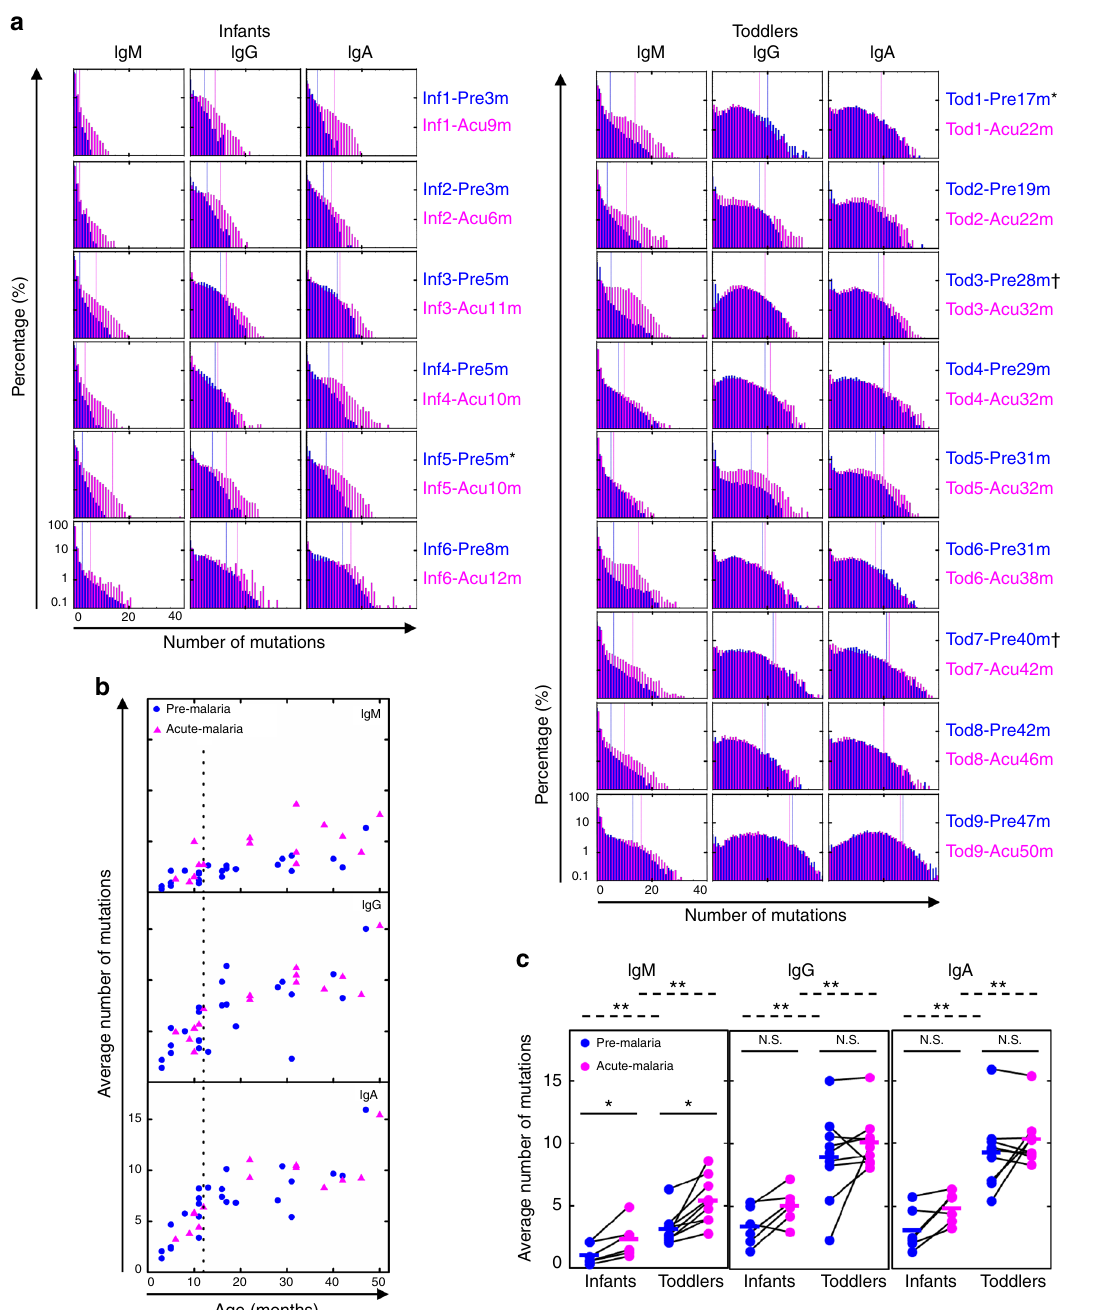
Fig. 2 Infants and toddlers are separated into two stages based on SHM load. a Distribution of SHM number for infants ( N = 6) and toddlers ( N = 9), from whom we had paired pre-malaria ( blue ) and acute ( pink ) malaria samples, weighted by unique RNA molecules. Blue and pink long vertical lines represent the number of mutations above which 10% of sequences fall for the respective samples. * and † demarcate samples derived from the same individuals followed for two malaria seasons. b Age-related average number of mutations in pre-malaria ( blue circle , N = 24, N Infant = 11, N Toddler = 13) and acute malaria ( pink triangle , N = 15, N Infant = 6, N Toddler = 9) samples, weighted by RNA molecules. Dashed line indicates the age boundary for infants ( < 12 months old) and toddlers (12 – 47 months old). c Comparison of average number of mutations for paired infants and toddlers. Pre- ( blue ) and acute ( pink ) malaria samples separated by isotype; lines connect paired samples ( N Infant,paired = 6, N Toddler,paired = 9). Bars indicate means. * P < 0.05, ** P < 0.01, N.S. indicates no signi fi cant difference by two-tailed Mann – Whitney U test (between age groups, dashed lines ) or two-tailed Wilcoxon signed-rank test (between paired time points, solid lines ). Differences in variance were not signi fi cant by squared ranks